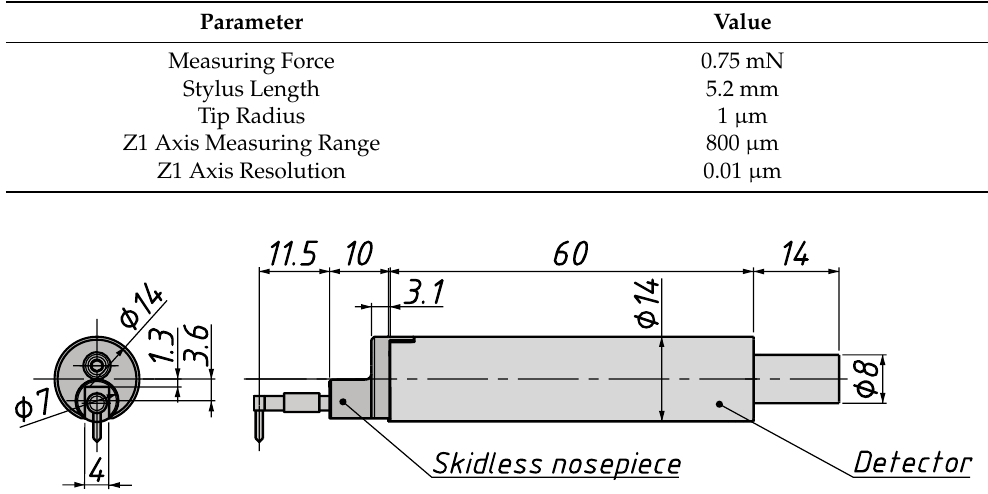
Figure 7. The 178-396-2 roughness detector with the standard stylus. Adapted from ref. [26]. Table 2. Specifications of the roughness detector.